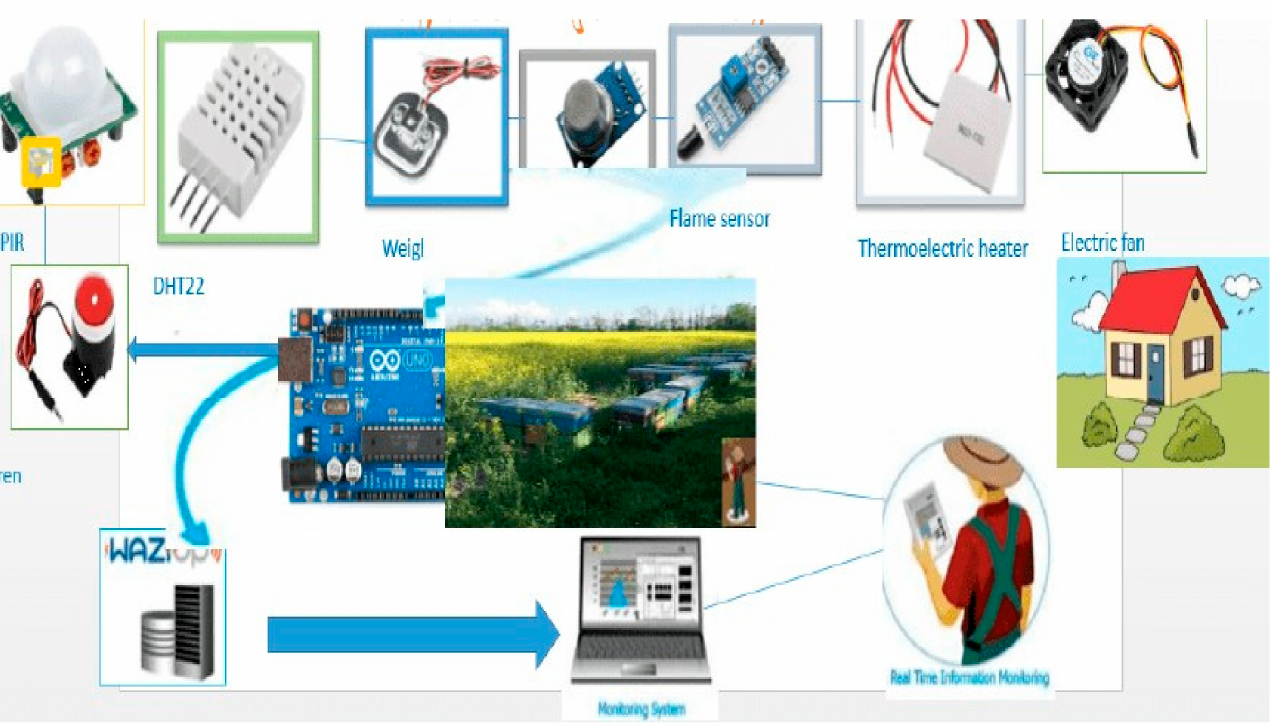
Figure 1. SBMaCS